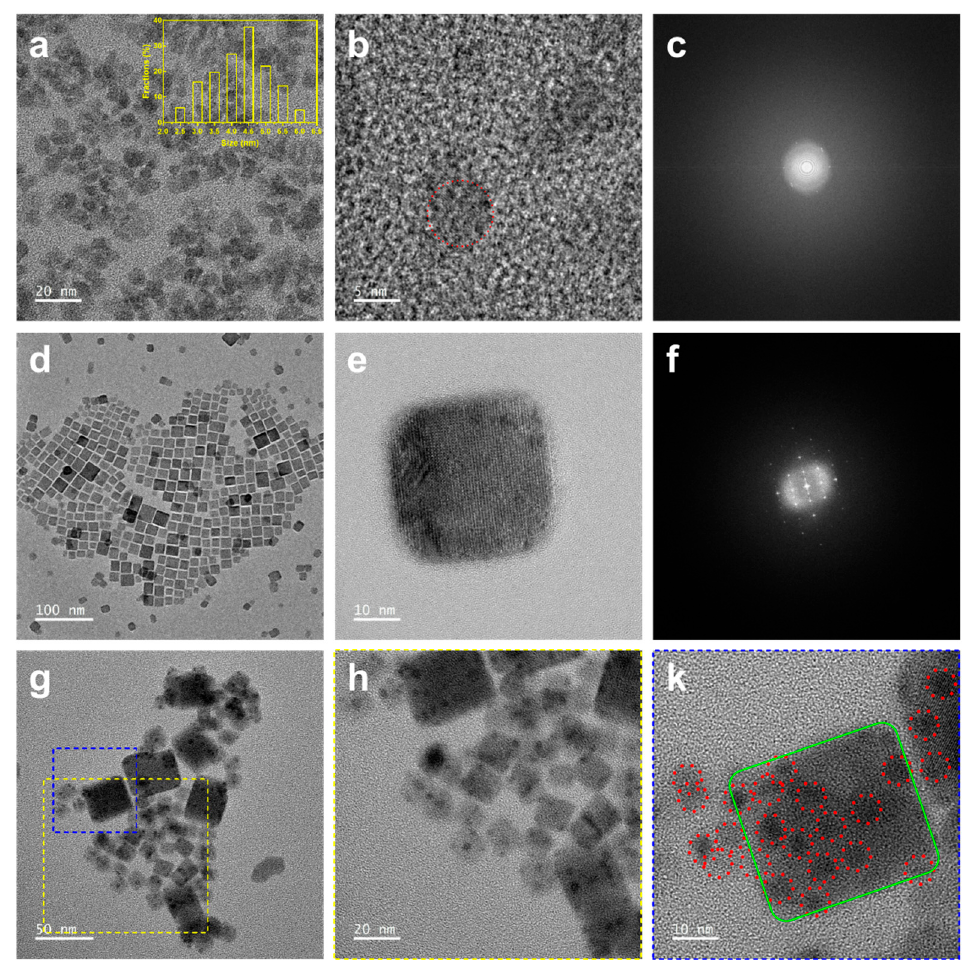
Figure 2. TEM, HRTEM, and Fourier transform images of typical carbon nanodots ( a ), ( b ), ( c ) (top row) and CsPbBr 3 ( d ), ( e ), and ( f ) (middle row). Bottom row shows an HRTEM image of the CsPbBr 3 / CD composite ( g ), a magnified HRTEM image of the yellow box in ( g ) (panel ( h )), and a magnified image of the blue box in ( g ) (panel ( k )). In ( k ), the dashed red circles and green-lined square outline the carbon dots and a CsPbBr 3 nanosheet, respectively.